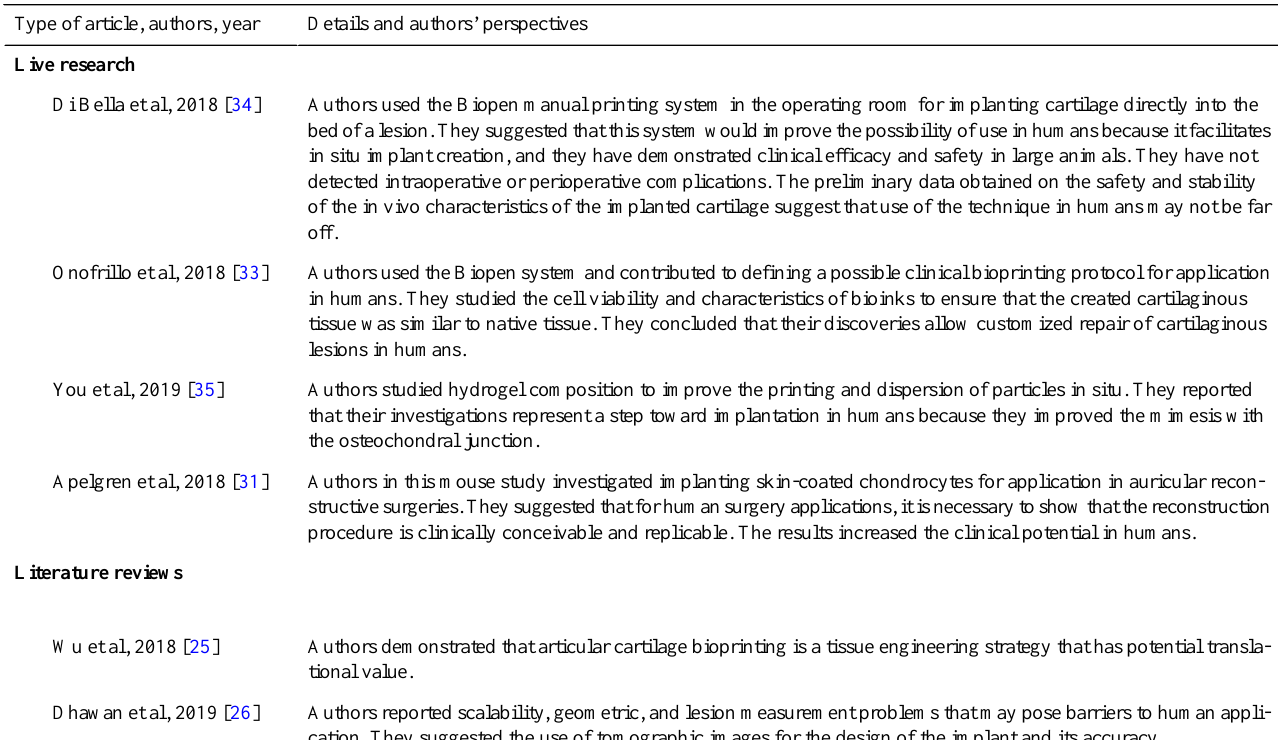
Table 3. Authors’perspectives about current research for human